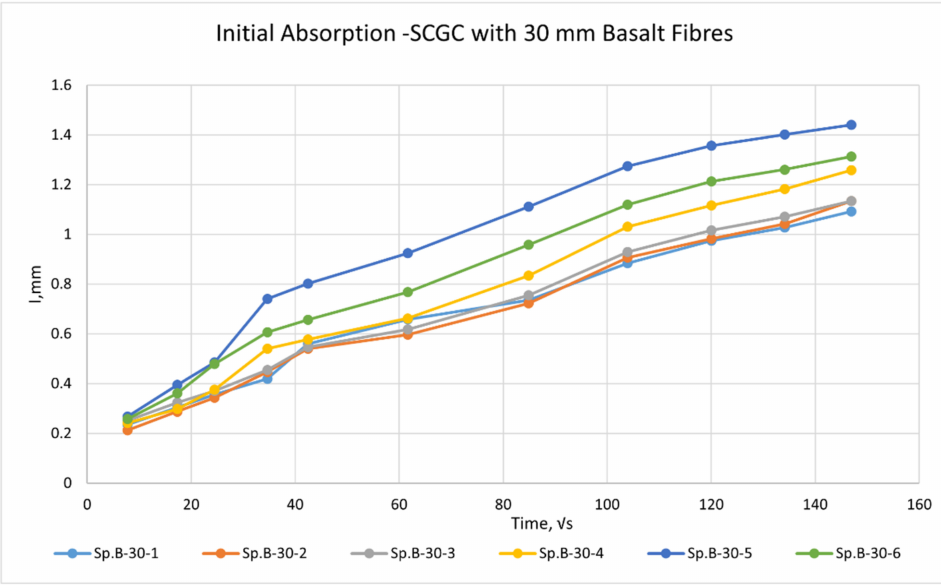
Figure 10. Initial absorption plot of SCGC with 30 mm basalt fibres.